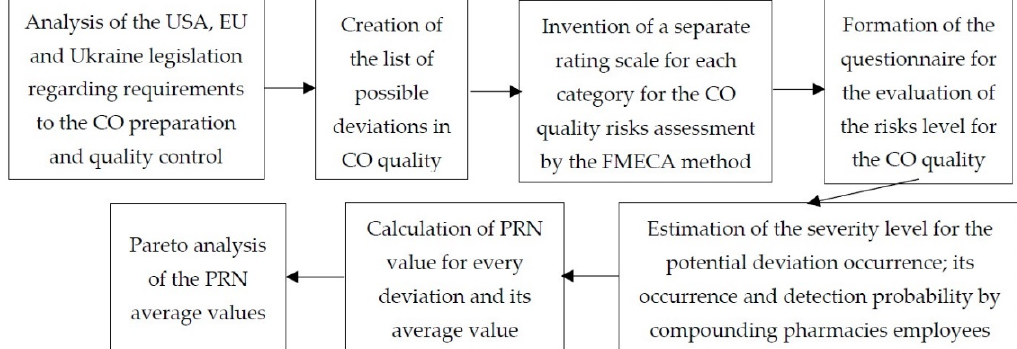
Figure 1. Research